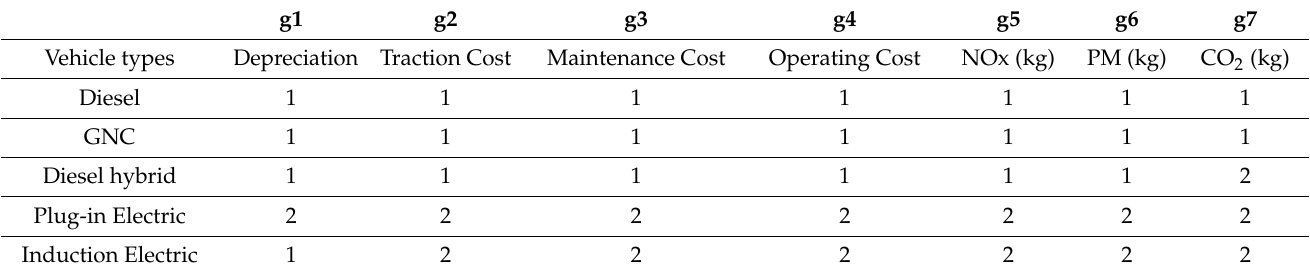
Table 15. The cluster 1 or 2 membership of the five vehicle types for each of the seven criteria. g1 g2